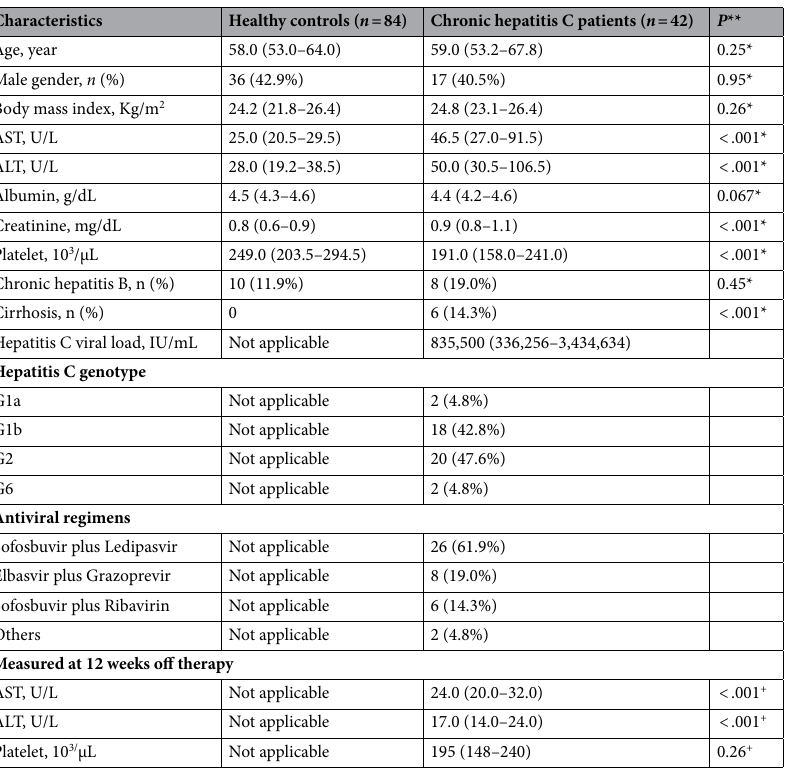
Table 1. Clinical characteristics of the study population. Data are expressed as median (interquartile range) or number (percentage). Abbreviations: ALT alanine aminotransferase, AST aspartate aminotransferase. **Mann–Whitney U test for continuous variables and Fisher’s exact test for categorical variable; *indicated comparison between healthy controls and patients with chronic hepatitis C; + indicated paired comparison for measurements before and 12 weeks after eradication of hepatitis C virus